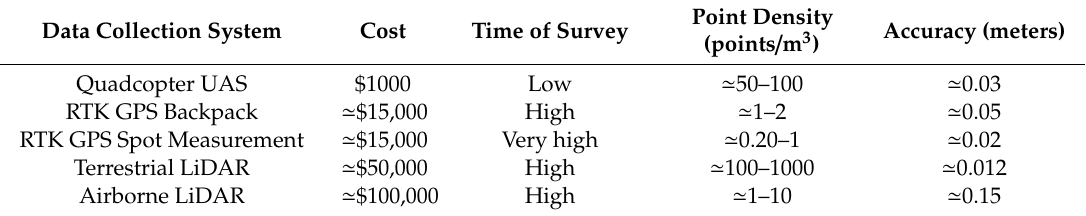
Table 1. Comparison of Surveying Systems and Associated Characteristics [3,7,8]. LiDAR: light detection and